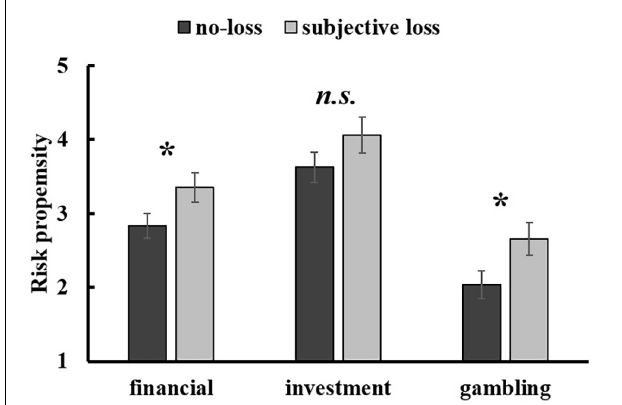
FIGURE 2 | Figure 2 . The loss effect on the overall financial risk propensity, risk propensity in investment, and risk propensity in gambling in Study 1. Error bars represent standard errors. n.s. p > 0 . 05, * p < 0 .